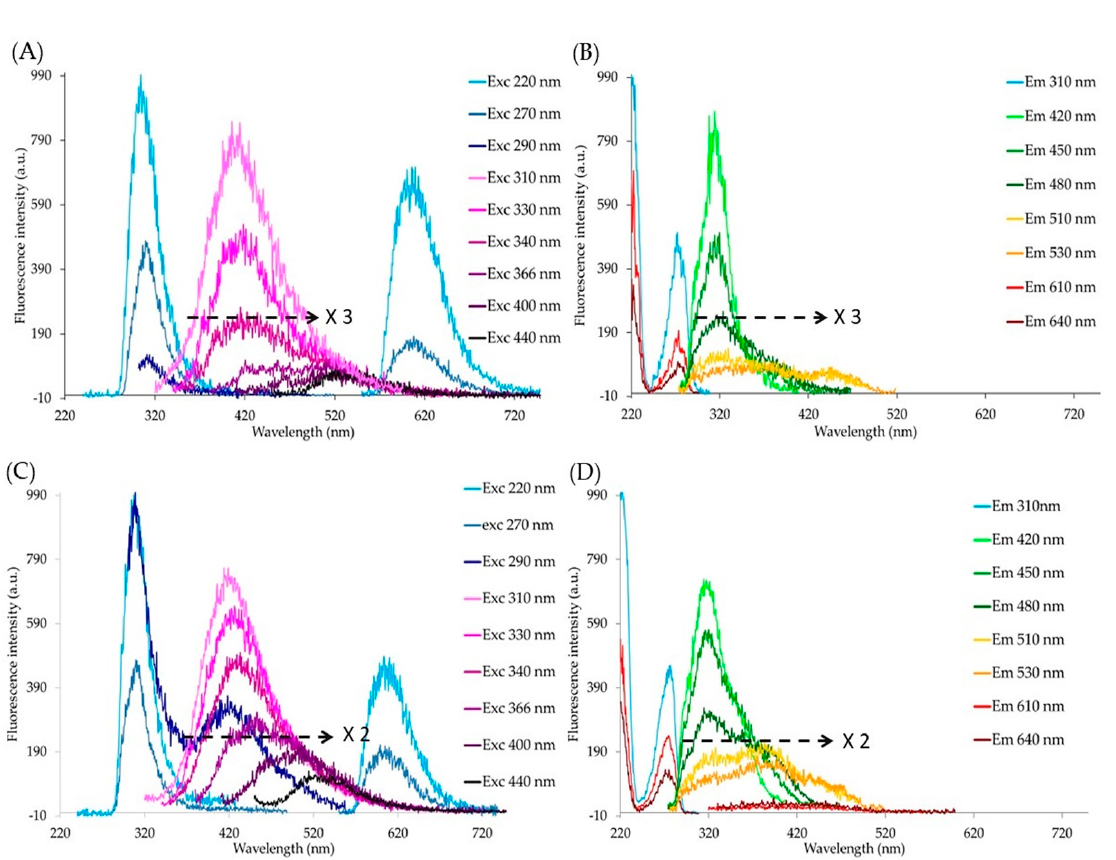
Figure 3. Emission ( A , C ) and excitation ( B , D ) spectra recorded during the melanization processes, at one ( A , B ) and six months ( C , D ) of L-tyrosine solution aging. To allow the shapes of the spectra covering the 320–620 nm range ( A ) and the 300–520 nm range ( B ) to be better appreciated, their amplitudes are increased with respect to the fluorescence intensity scale values, as indicated by the arrow in each panel. Excitation and emission conditions are indicated by colors on the right.